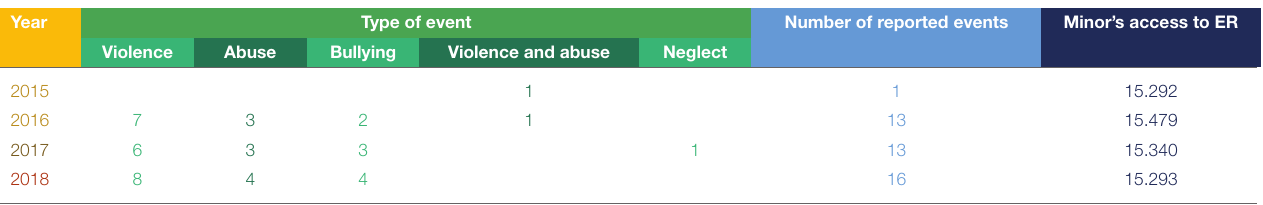
TABLE 1 | Number of events/year and the type of event compared to the total amount of minors’ accesses to the Emergency